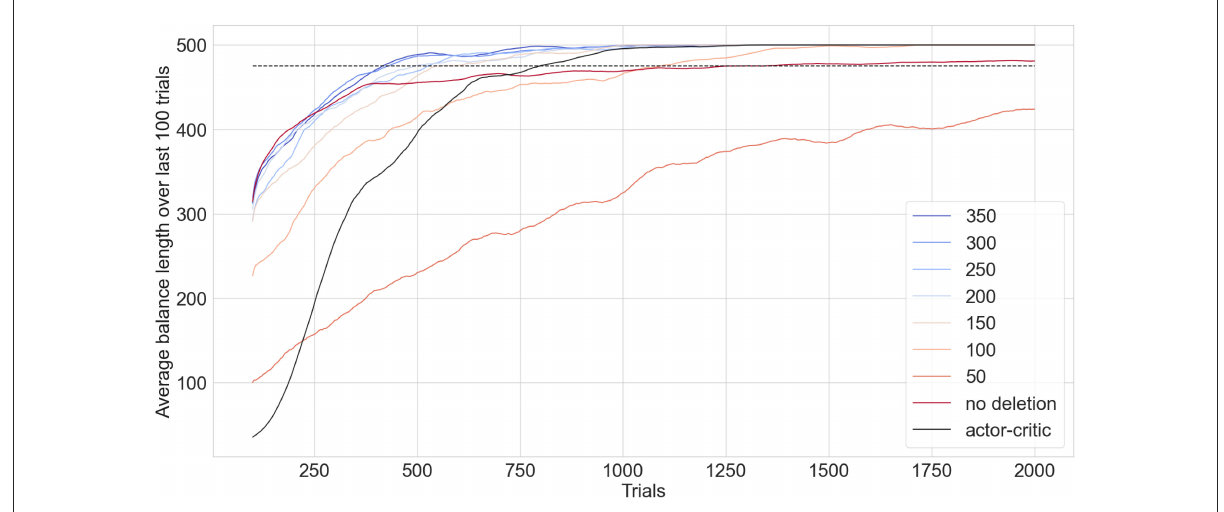
FIGURE10 EDN with varied network size limits benchmarked against an ANN trained in tensorflow using an actor-critic model (black) applied to the inverted pendulum task. The lines show the running average of the last 100 trials with the dashed line showing the threshold performance required for the task to be considered solved. Each configuration is repeated 100 times and the average of their performance is